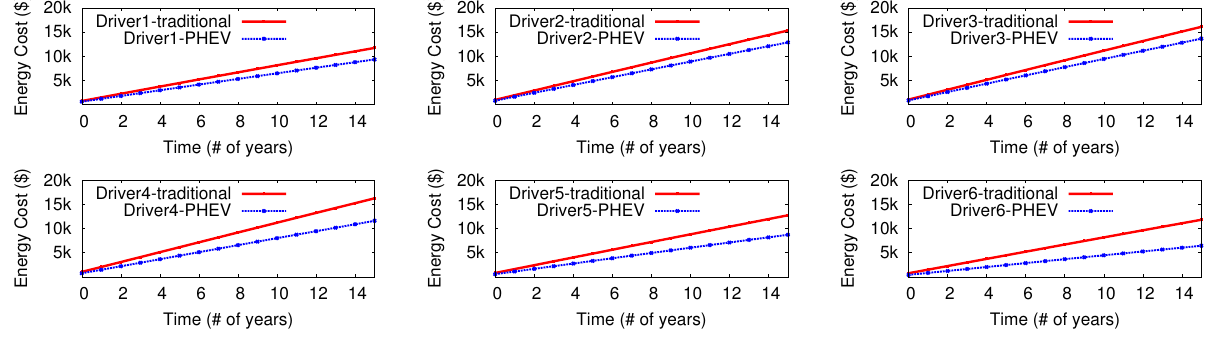
Figure 16. Energy economy comparison between conventional vehicle and